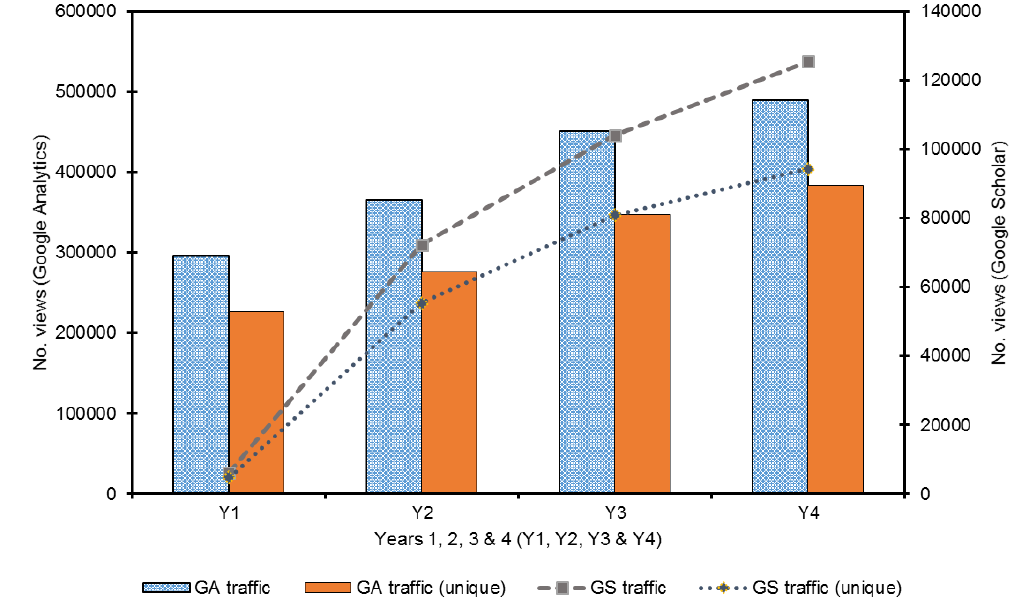
Figure 2. Volume of Google and Google Scholar referral traffic , including unique traffic in Y1, Y2, Y3 and